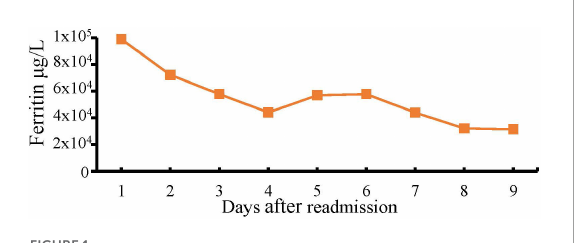
FIGURE1 Down-trending ferritin levels after hospital